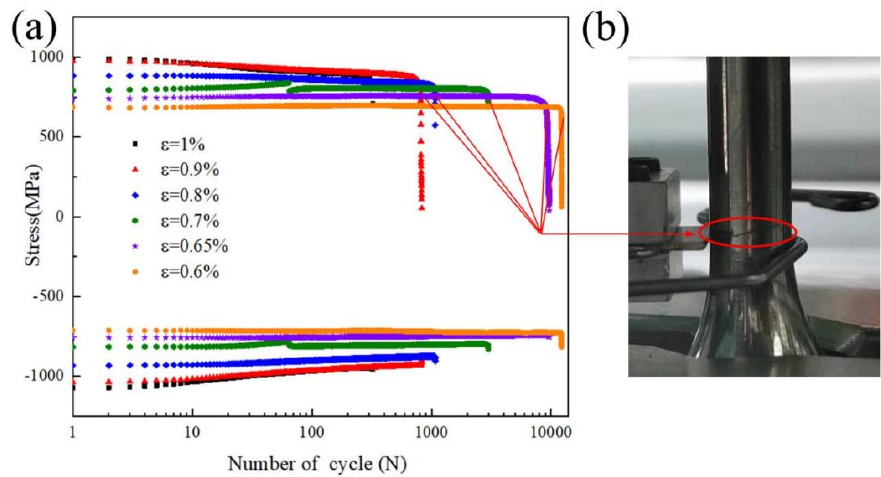
Figure 6. ( a ) Cyclic maximum tensile and compressive stress curves; ( b ) image of LCF sample crack.